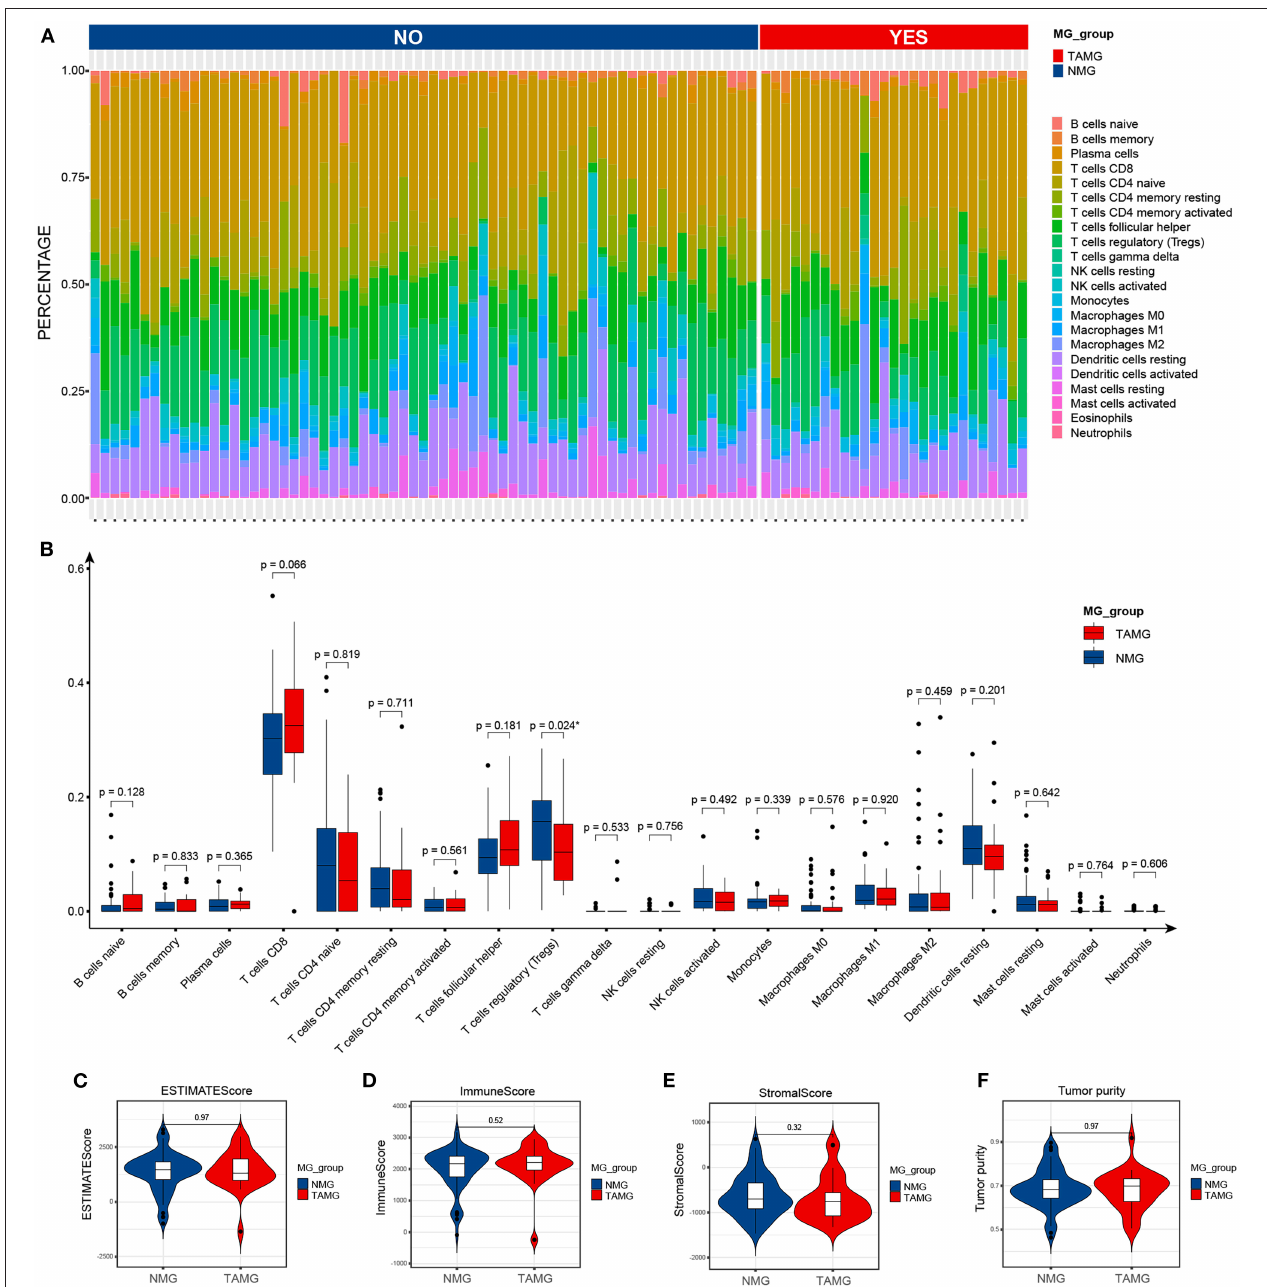
FIGURE 4 | Immune features of thymoma in patients with TAMG. (A) Bar plots show the composition of immune cells predicted by using the CIBERSORT algorithm in thymoma of TAMG and patients with NMG. (B) Box plots denote the estimated proportion of immune cells in thymoma between patients with TAMG and NMG. Violin plots demonstrate the ESTIMATE score (C) , immune score (D) , stromal score (E) and tumor purity (F) calculated by use of the ESTIMATE algorithm.